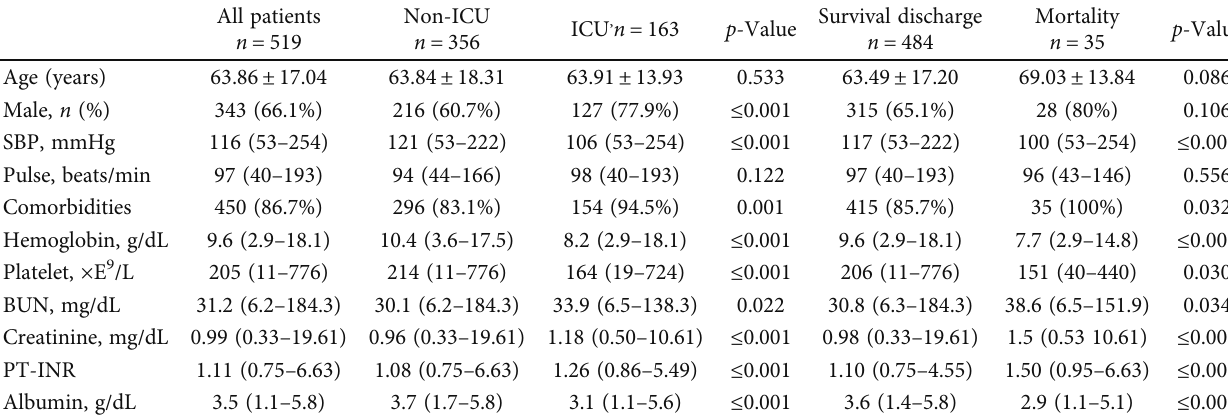
Figure 1: Patient inclusion fl owchart. Table 1: Patient